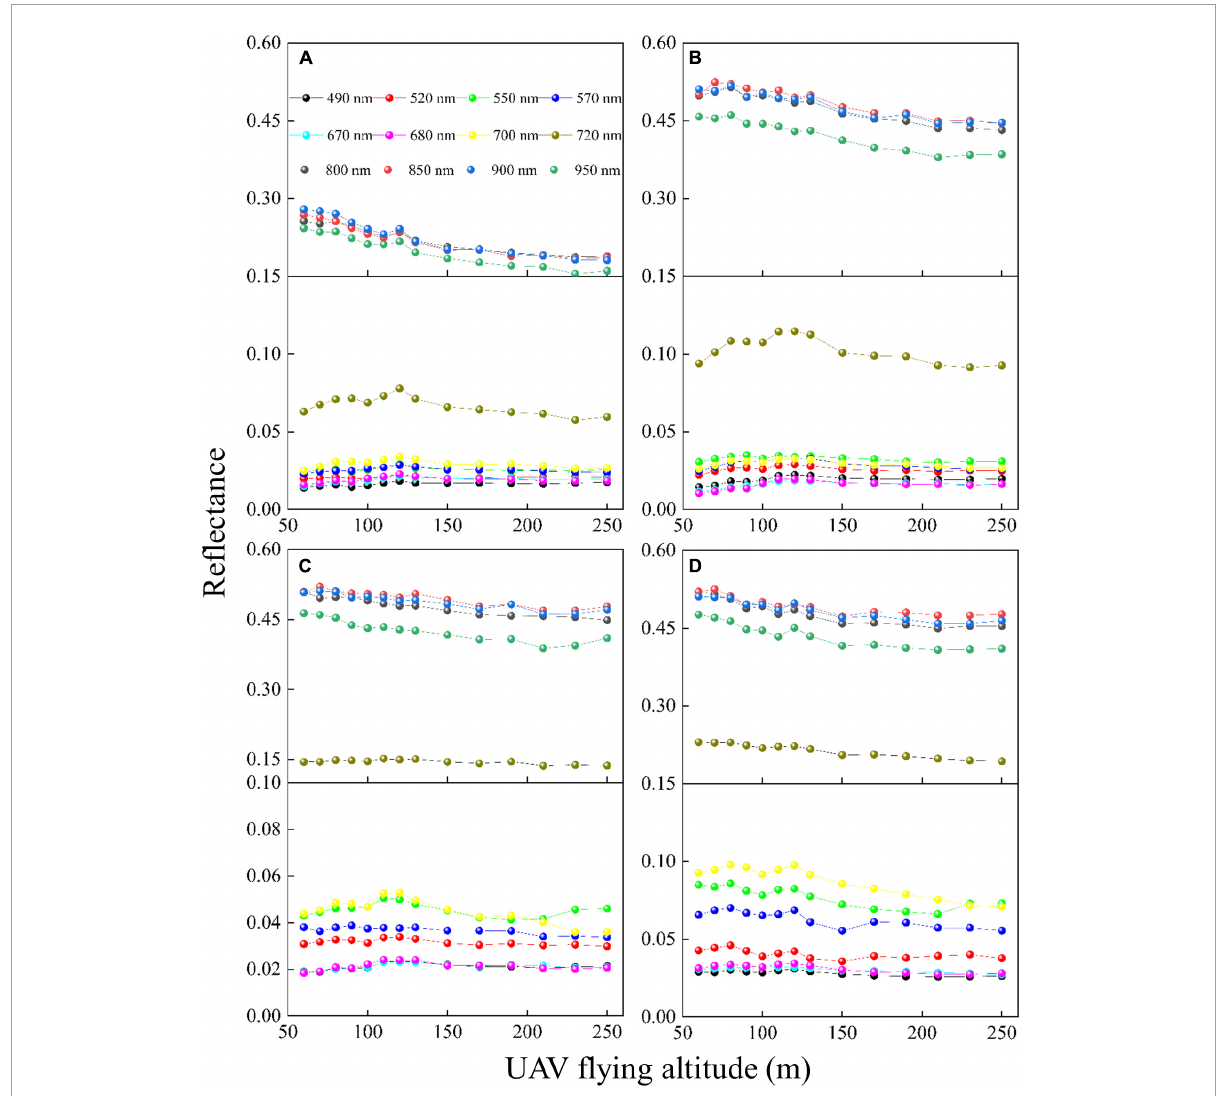
FIGURE2 Variation in reflectance of rice with different UAV-FAs at (A) tillering stage; (B) jointing stage; (C) heading stage; and (D) milking